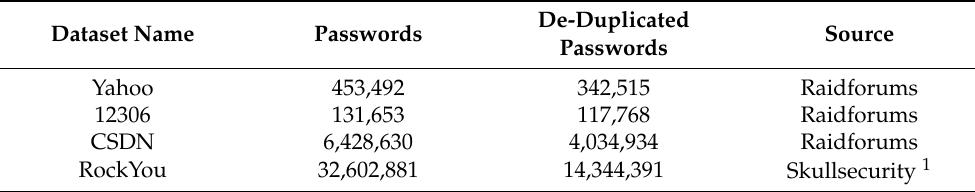
Table 2. Leaked password dataset